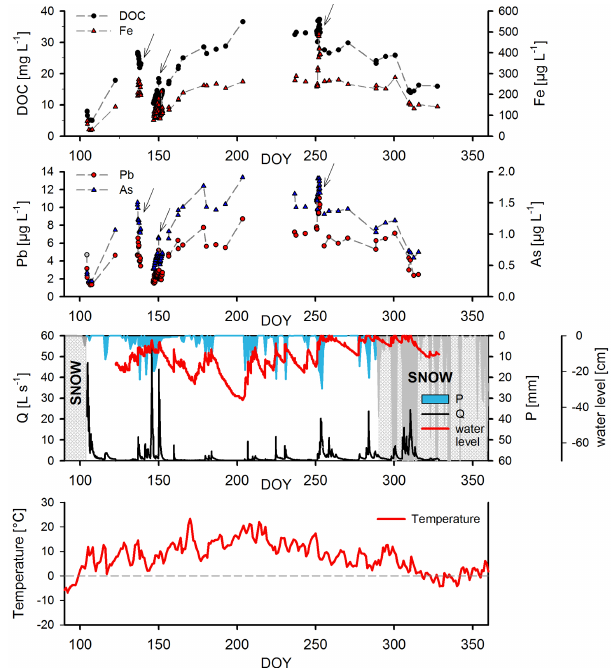
Figure 2. Annual concentration record of DOC, Fe, Pb and As (top and upper middle panels) at the bog outlet. Annual records of bog water level, daily precipitation, discharge and temperature (bottom and lower middle panels). Sampled discharge events are highlighted by black arrows. Note that winter precipitation as snow cannot be